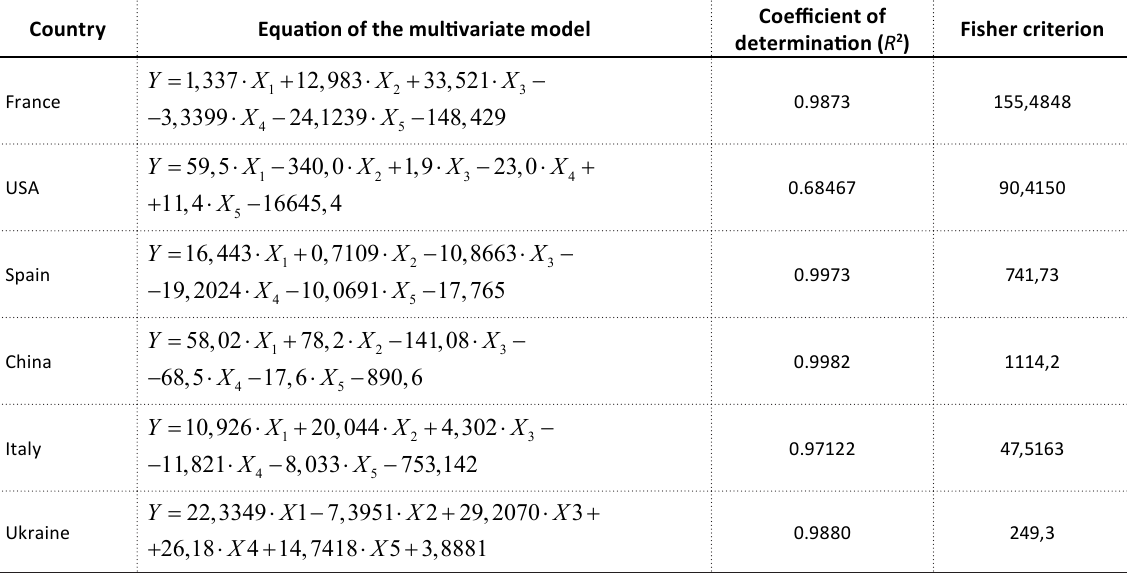
Table 4. Modelling the impact of tourism on GDP